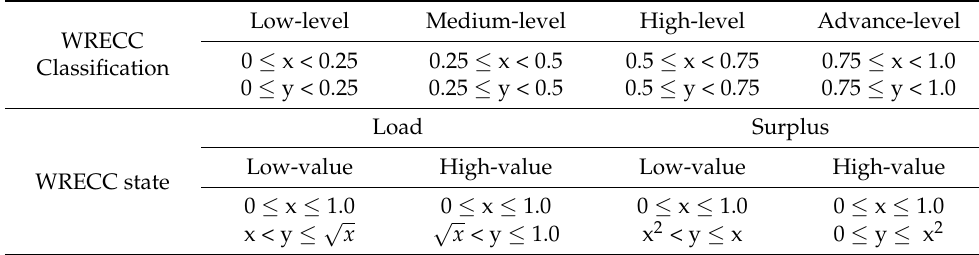
Figure 2. Schematic diagram of clarification of the WRECC indicator based on the support-pressure model. Here, (I), (II), (III), and (IV) represents four different regions of pressure index. Table 2. Clarification and status of the WRECC indicator.